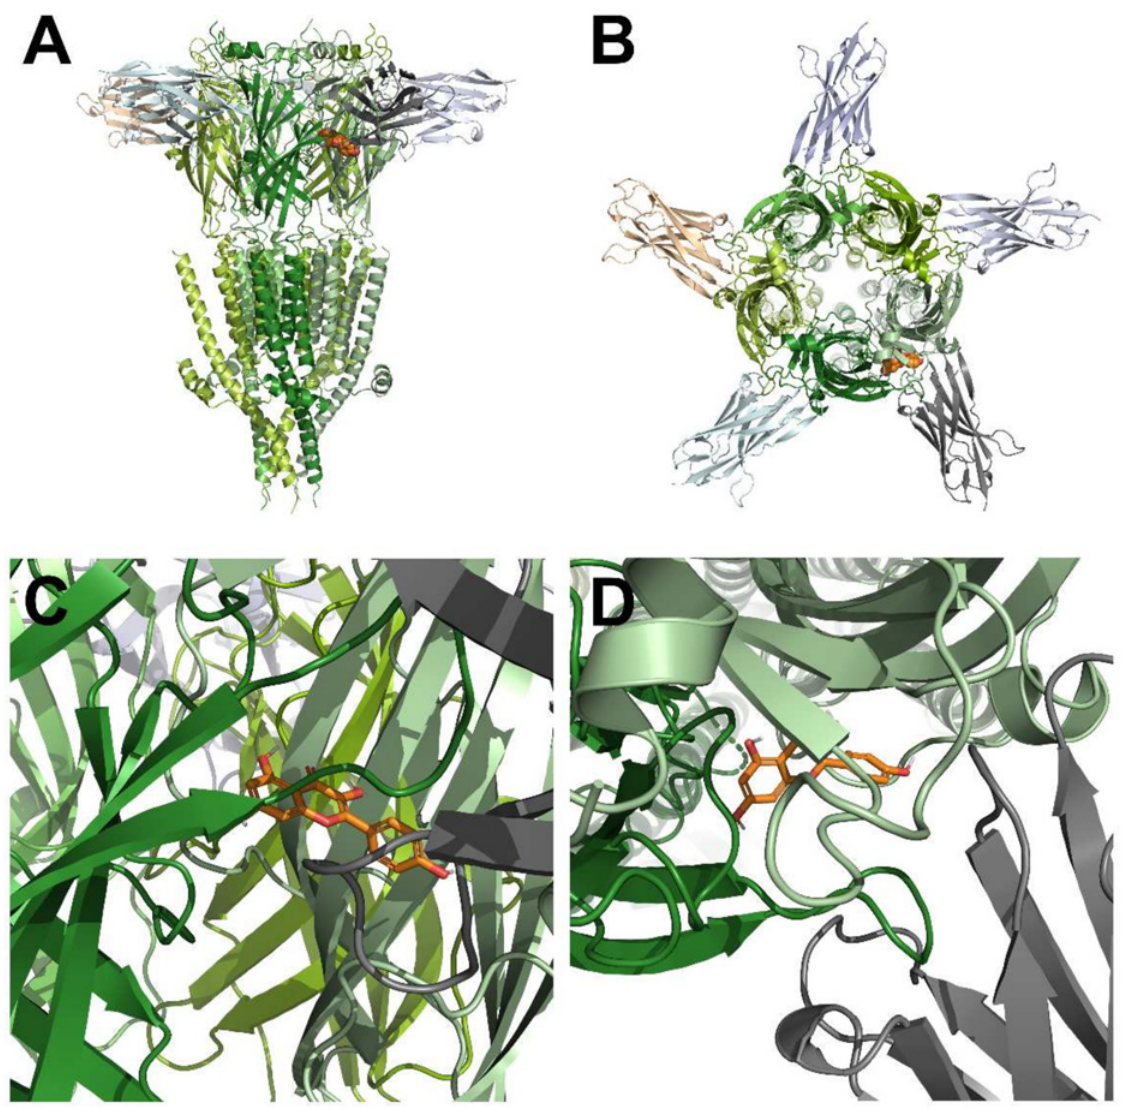
Figure 3. 3D docking modeling of KAE on human 5-HT 3A receptor. ( A – C ) Docked complex of 5-HT 3A receptor and KAE from the side. ( B – D ) Docked complex of 5-HT 3A receptor and KAE from the